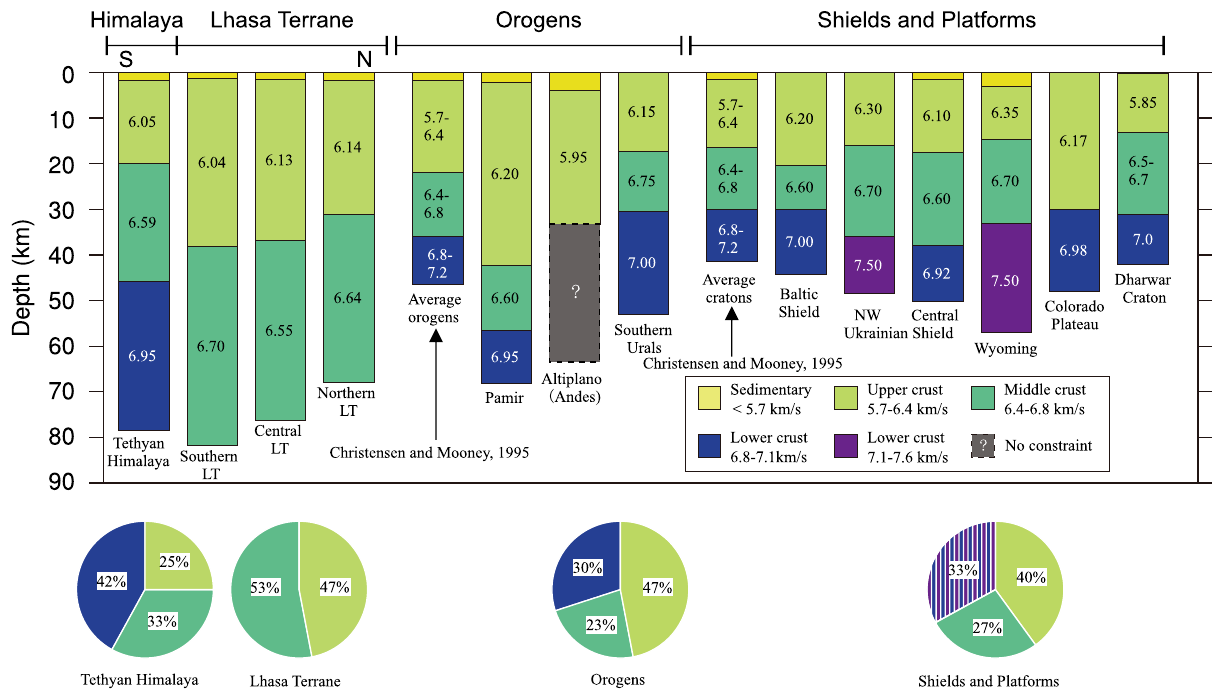
Fig. 3 Vertical crustal seismic compressional velocity sections. Velocity sections for different parts of the study area shown together with vertical models from other regions with thick crust (Moho depth >45km) and the Dharwar Craton in India 7 , as well as the global average crustal structure 8 of orogens and cratons. LT Lhasa Terrane, NW Northern-western. Only the velocity sections for the Lhasa Terrane lack a high-velocity lower crust corresponding to a ma fi c composition, which makes its structure